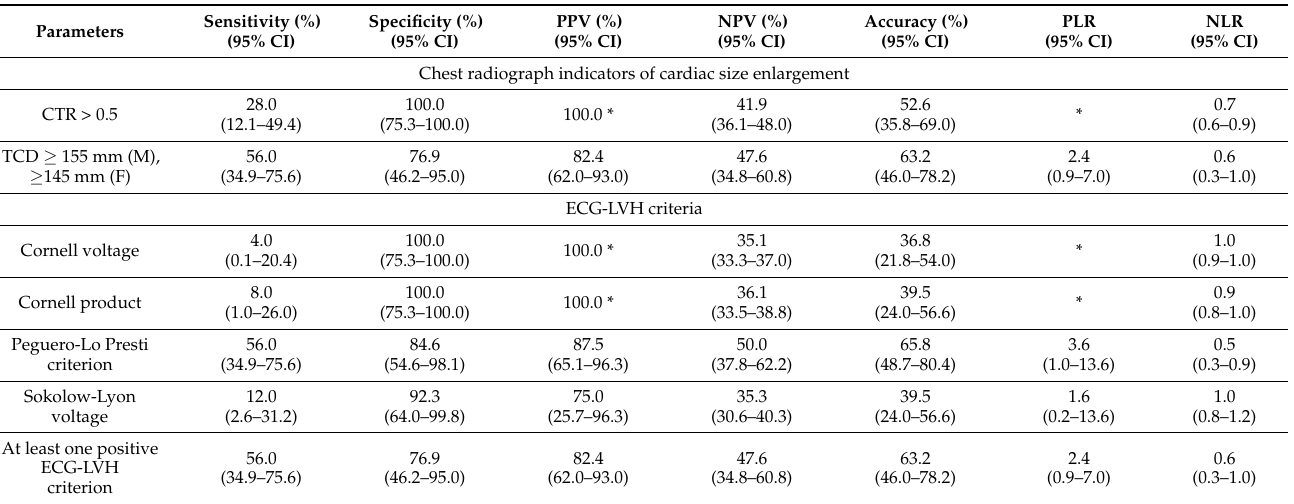
Table 4. Radiographic and electrocardiographic criteria in the screening for left ventricular hypertro- phy and their sensitivity, specificity, positive predictive value, negative predictive value, accuracy, positive likelihood ratio and negative likelihood ratio. Data are shown for indexed left ventricular mass by body surface area.